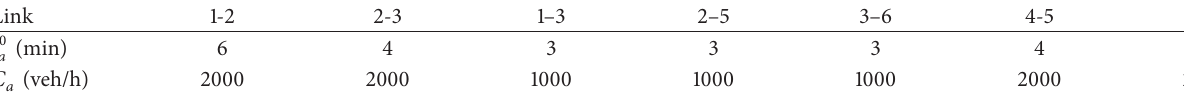
Table 2: Attributes of links.